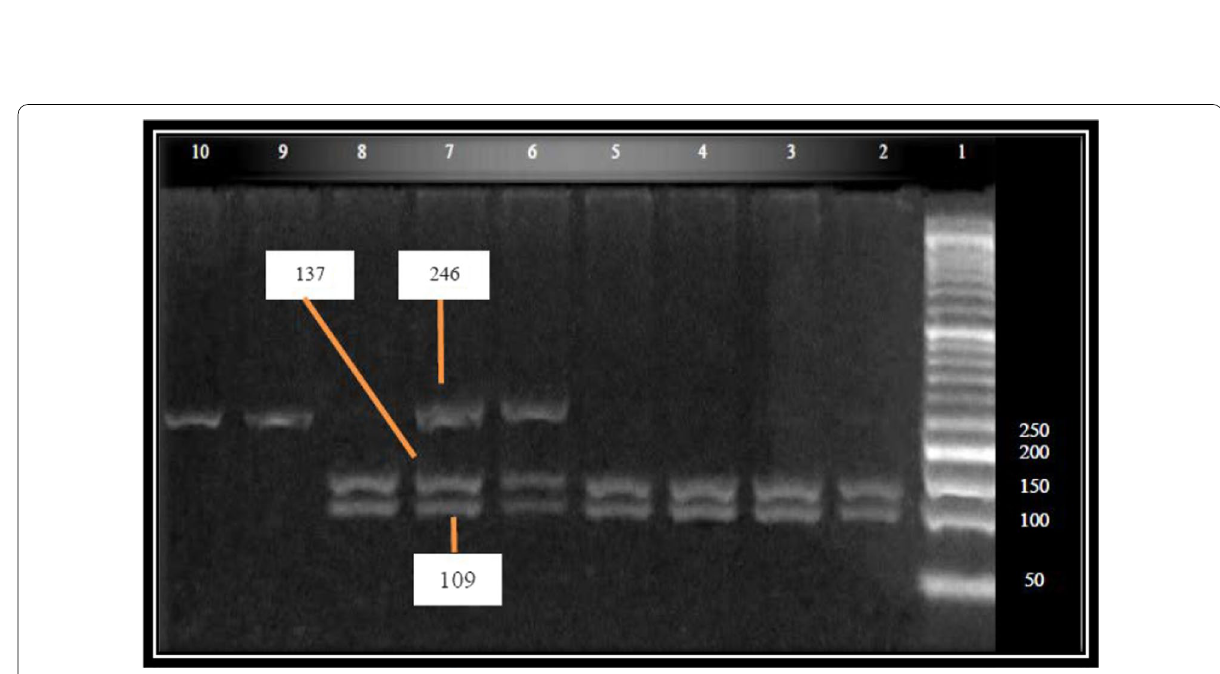
Fig. 2 PCR–RFLP band pattern of CDKN2A/B gene polymorphism (rs2383208) on a 3% agarose gel. Lines 1: Marker of DNA. Lines 9 and 10: GG genotype 246 bp, Lines 2, 3, 4, 5 and 8: AA genotype 137 and 109 bp. Lines 6 and 7: AG genotype 240, 137 and 109